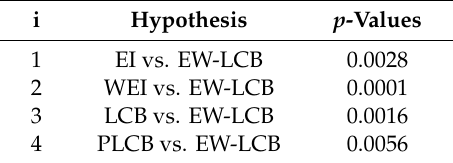
Table 5. The p -values obtained in the numerical examples by the di ff erence significance test.